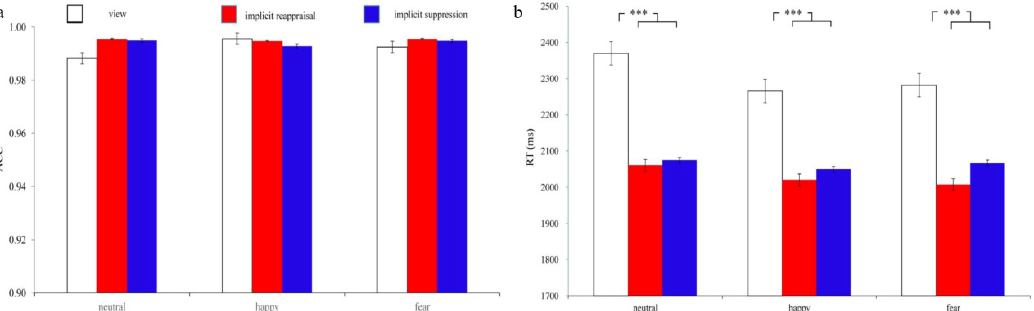
Figure 2. The ACC ( a ) and RT ( b ) of completing the MCE task under view (white bar), implicit reappraisal (red bar), and implicit suppression (blue bar) conditions. “***” means “ p <